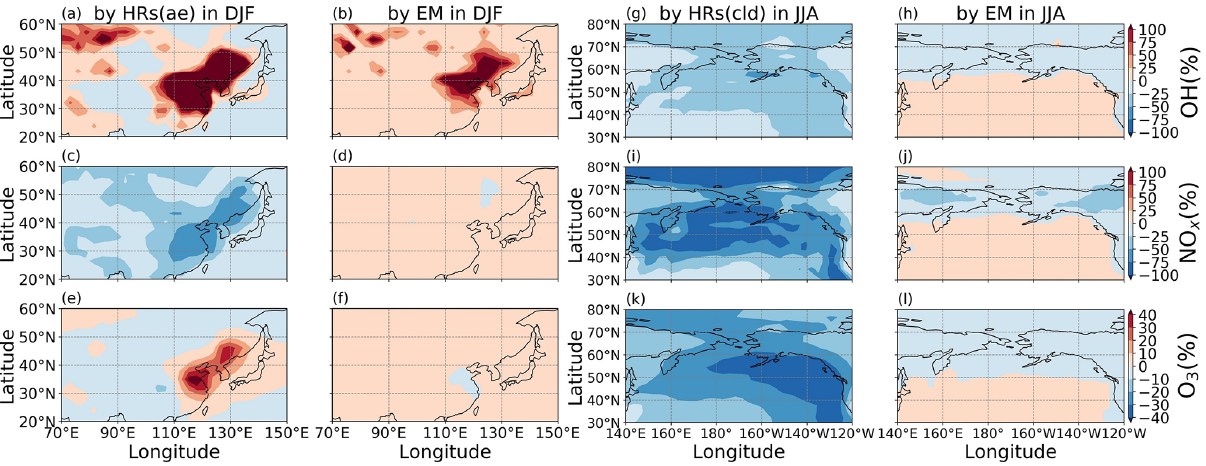
Figure 15. Effects of HONO photochemistry for the surface layer, for OH (a–b, g–h) , NO x (c–d, i–j) , and O 3 (e–f, k–l) over the northeastern China region in DJF (a–f) and the NP region in JJA (g–l) from dominant pathways of HONO by heterogeneous reactions of aerosols (a, c, e) , heterogeneous reactions ice and clouds (g, i, k) , and direct HONO emission (b, d, f, h, j, l) .